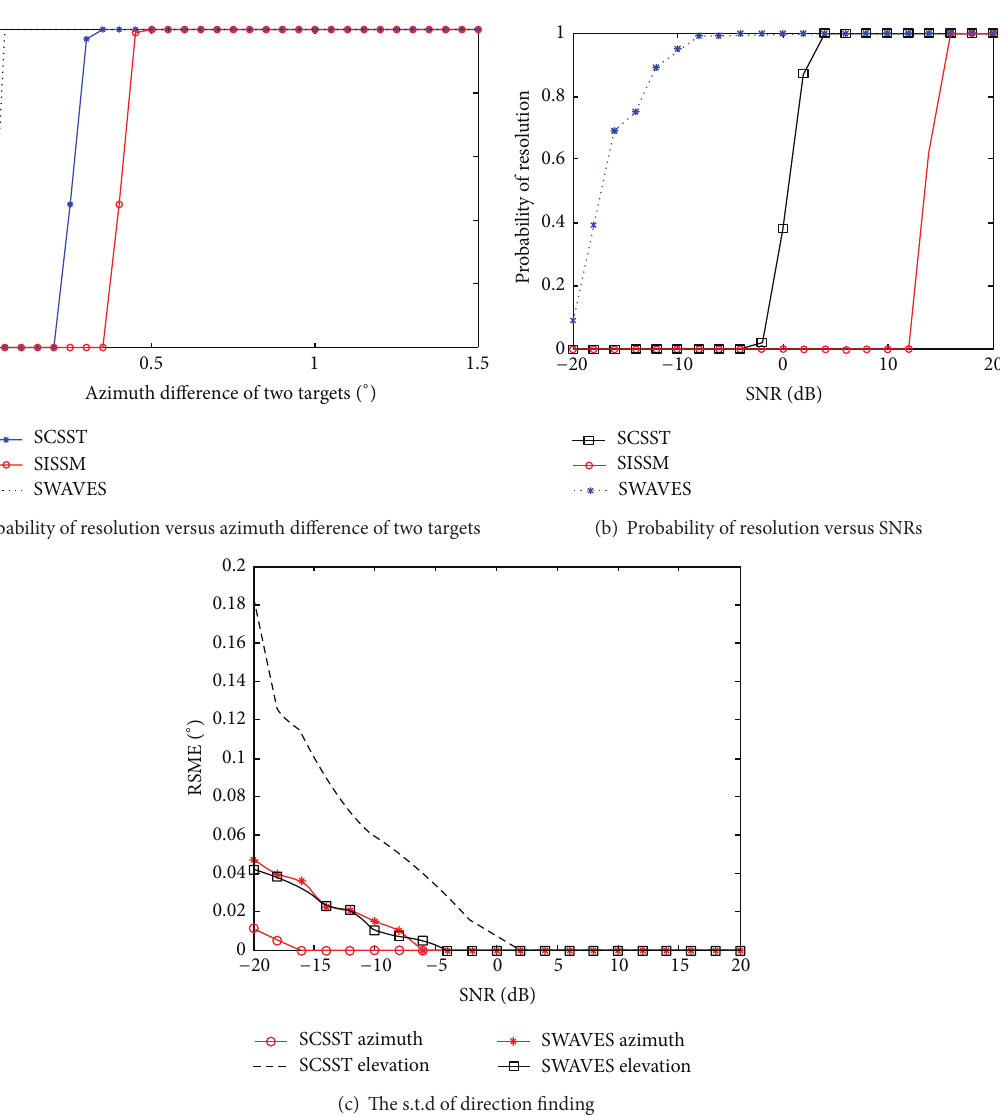
Figure 18: Contrast of performances of three broadband subarrayed superresolution